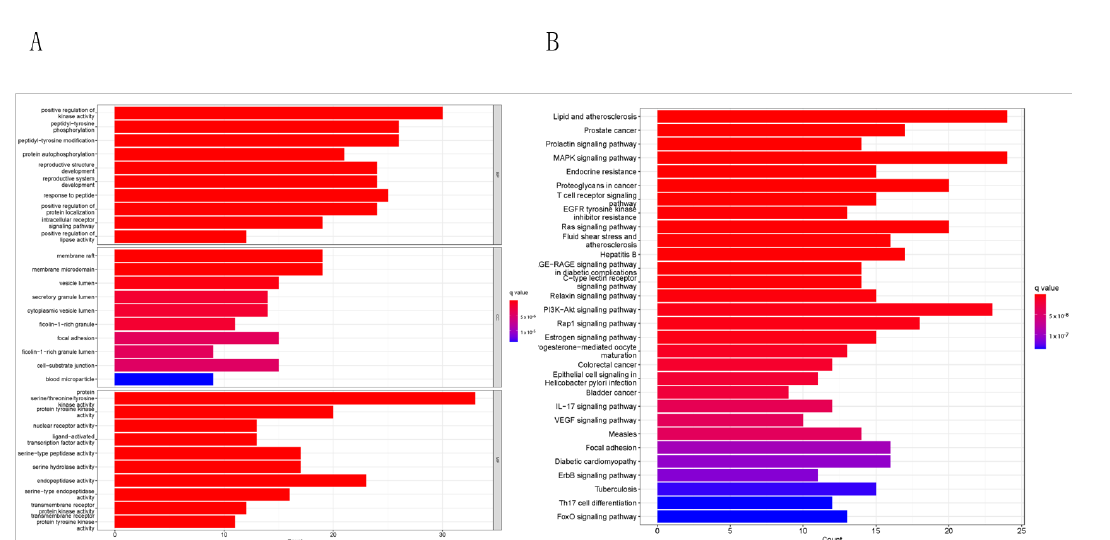
Figure 3. ( A ) The bar plot diagram of GO analysis of BDMC-UC, including the top 10 important enrichment terms of BP, CC, and MF. Redder means lower q value. ( B ) KEGG enrichment analysis for the major target of BDMC (top 30). Redder means lower q value.